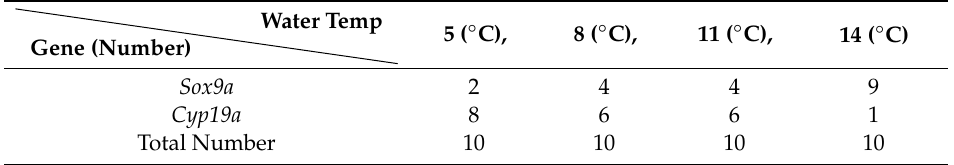
Figure 4. Sox9a and cyp19a mRNA expression in the juvenile fish samples. ( A ) The sample in females when cyp19a induction is greater than sox9a induction at 5 ◦ C. ( B ) The sample in males when sox9a induction is greater than cyp19a induction at 14 ◦ C. Kruskal–Wallis with post-hoc Dunn’s multiple comparison tests were used. The expression of each sample was relative quantity to the expression of 18s rRNA Values are reported as mean ± SD of the three experiments. * indicates p < 0.05, ** indicates p < 0.01, *** indicates p < 0.001. Table 2. Number of individuals based on the expression of sox9a and cyp19a in each water temperature. Individuals were counted between higher expression levels for sox9a and cyp19a . Gene expression was examined by randomly selecting 10 fish from each